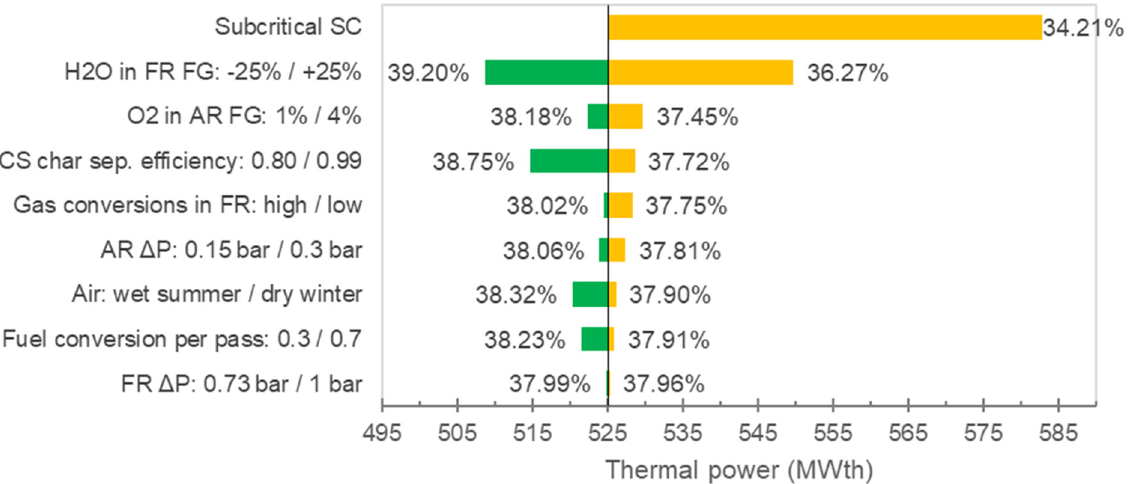
Figure 7. Effect of the modification of various parameters on the expected thermal power needed to reach the same net electricity production as in the reference case (199.4 MWe) for petcoke CLC. The data labels show the corresponding process net efficiency. The green bars correspond to the left-hand-side scenarios, while the yellow bars correspond to the right-hand-side scenarios.